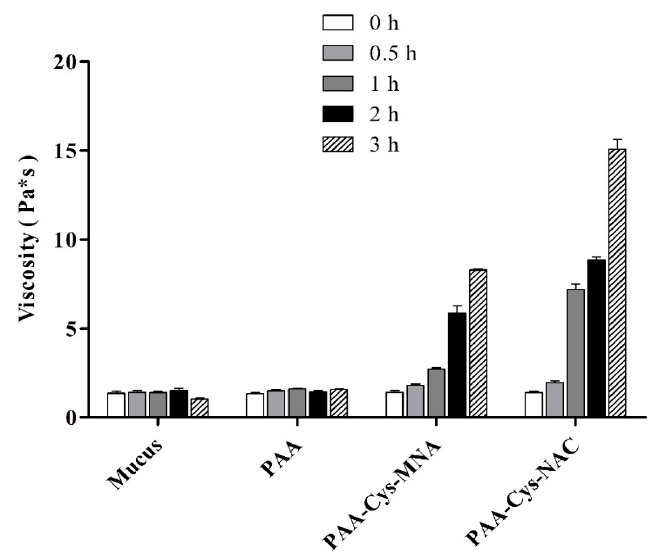
Figure 7. Viscosity of 1% m/v PAA and S-protected thiolated PAA conjugates incubated with mucus at 37 °C for indicated time points. Solutions were prepared in 50 mM phosphate buffer pH 6.8. Mucus incubated with buffer was used as control. The data are shown as mean ± SD (n = 3).